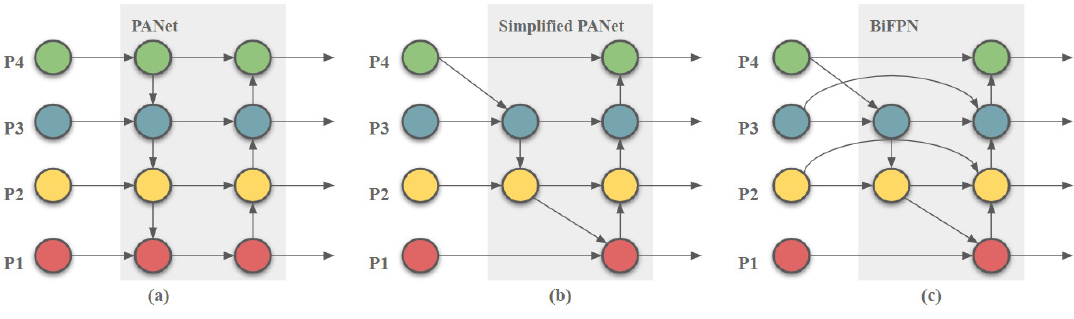
Figure 3. Formation process of BiFPN: ( a ) PANet; ( b ) simplified PANet; and ( c ) BiFPN.